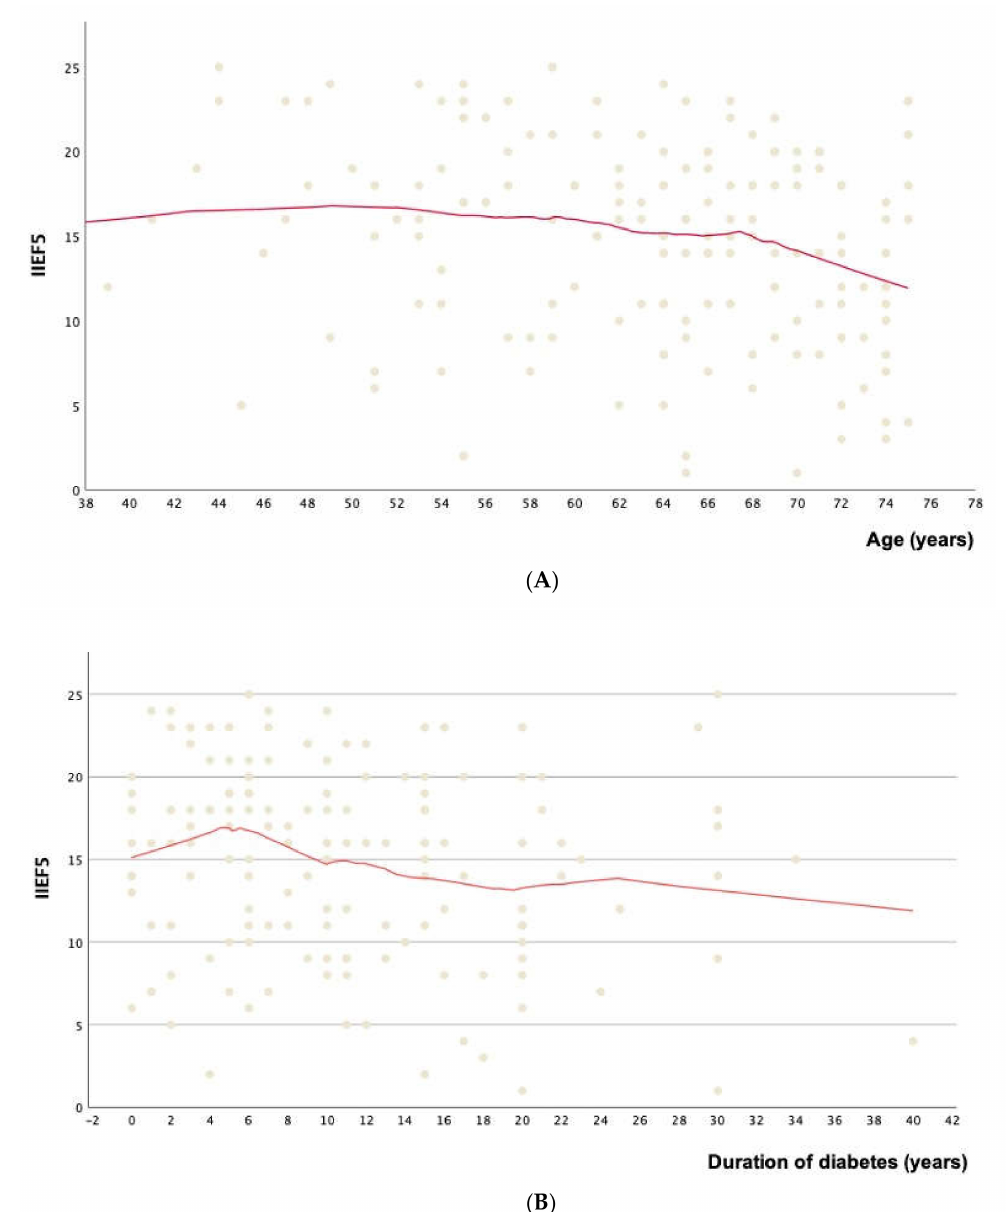
Figure 1. IIEF-5 score according to age ( A ) and duration of DM ( B ). Each dot in the dispersion plot in ( A ) identifies the International Index of Erectile Function (IIEF)-5 in each patient according to his age. The same outcome is reported according to the duration of diabetes in ( B ). The red lines represent the locally estimated scatterplot smoothing (LOESS) regression curve, with a fit to 50% of the points and an Epanechnikov weight